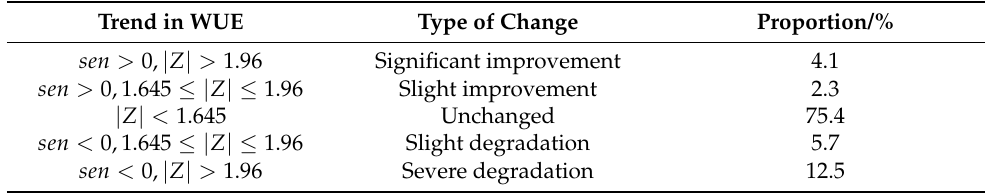
Table 3. Statistical result of Sen trend analysis and M-K test.